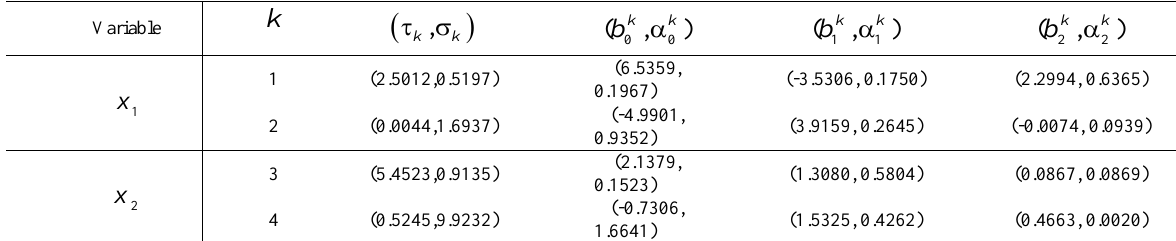
Tables 2. Premise and consequence parameters obtained using FWGALP